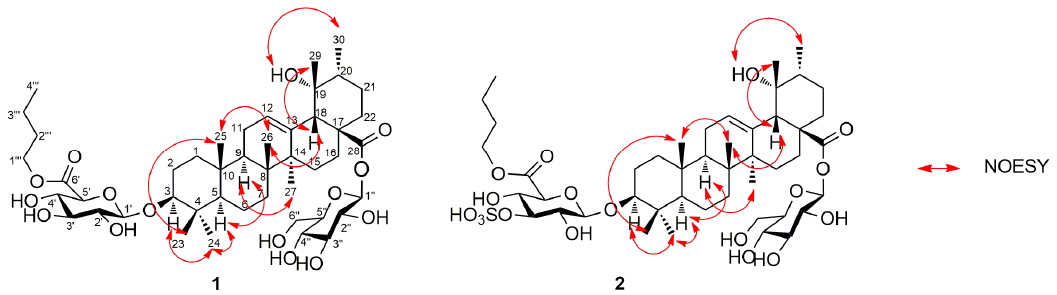
Figure 2. Key NOESY correlations of 1 and 2 .